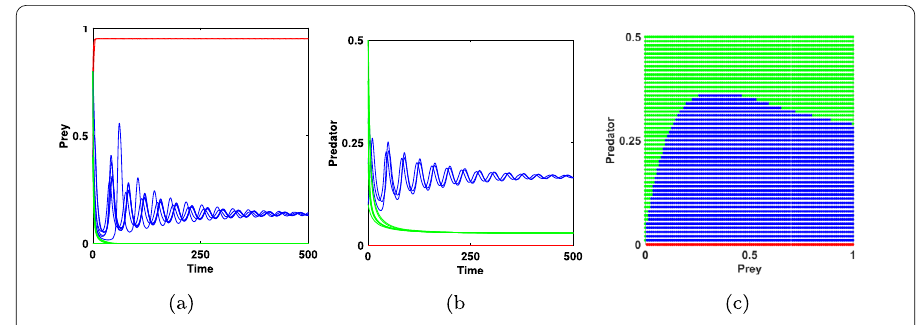
Figure 7 ( a ) and ( b ) Time trajectories for prey and predator populations with various initial conditions, where green curves are the trajectories approaching ¯ E , blue curves are the trajectories approaching E 2 , and red curves are the trajectories approaching ˆ E . ( c ) Bi-stability region in prey vs predator plane, i.e., initial conditions green, blue, and red points approach ¯ E , E 2 , and ˆ E respectively